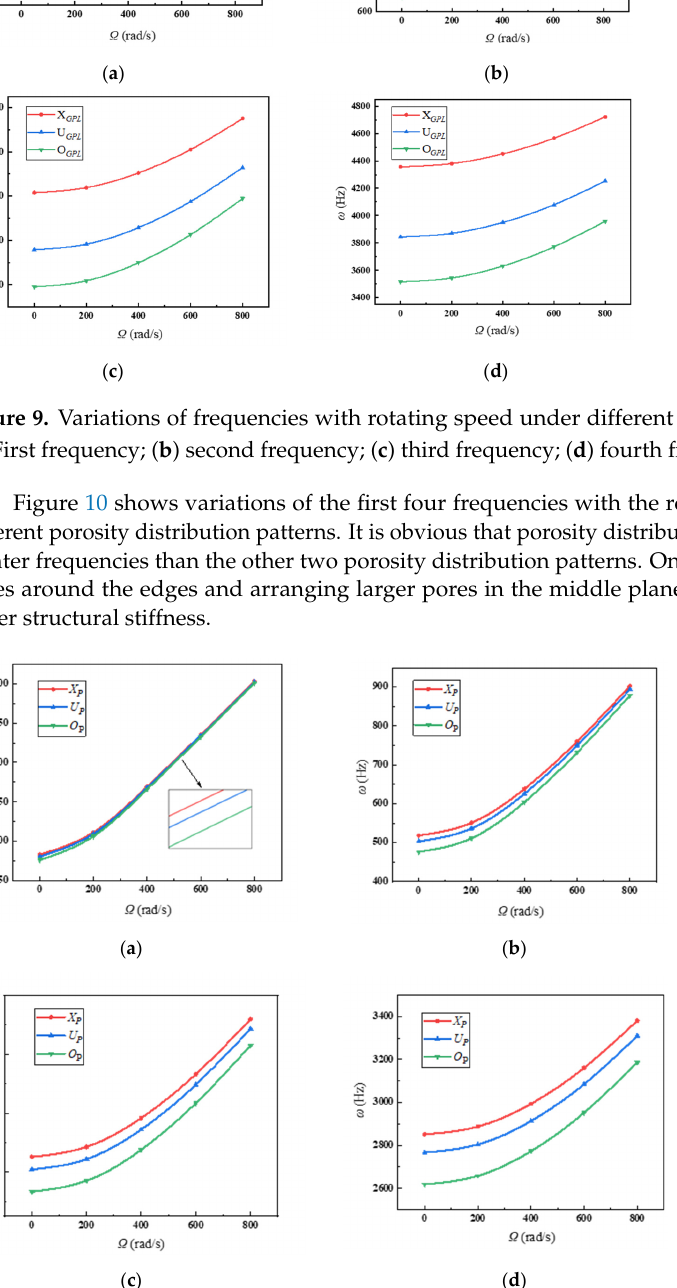
Figure 10. Variations of frequencies with rotating speed under different porosity distribution pat- terns. ( a ) First frequency; ( b ) second frequency; ( c ) third frequency; ( d ) fourth frequency. Variations of the first four frequencies with the rotating plate in the case of length-to- thickness ratio of the plate are given in Figure 11, where the blade length is constant. Lower length-to-thickness ratio of the plate shows greater frequencies. It indicates that